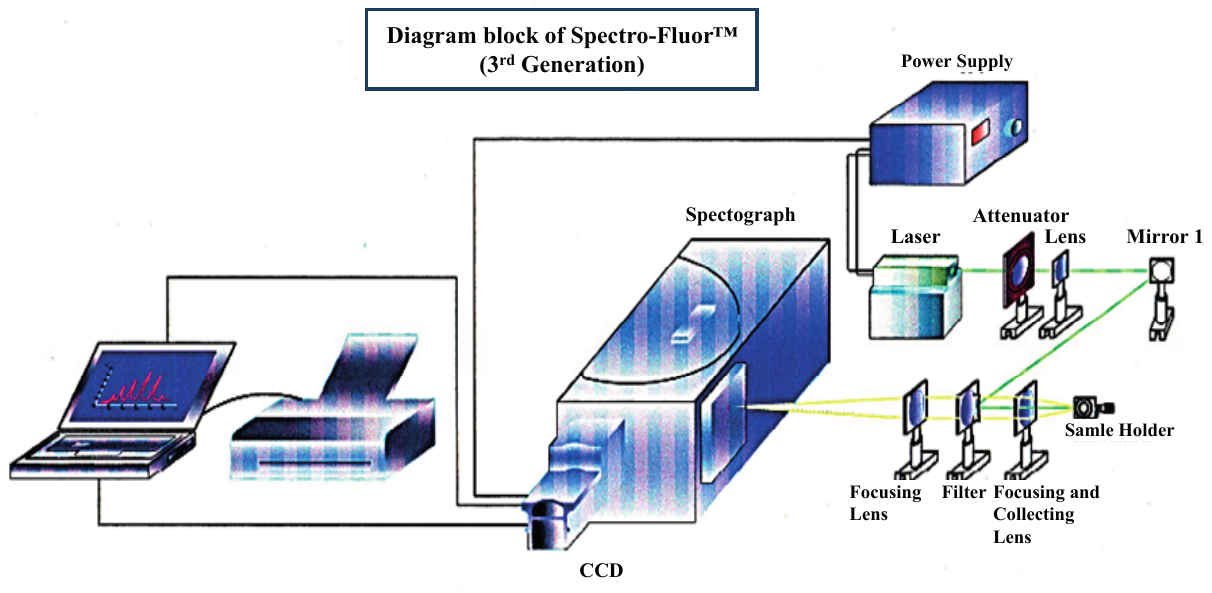
Figure 1. 3D-diagram of the Spectro-Fluor™ technology. This patented apparatus represents the third generation of the device, and includes a laser with power unit, a spectrograph, an ICCD camera with image intensifier, a desktop computer with appropriate software for data analysis. The next generation will represent a compact and portable device with focusing lenses replaced by fiber